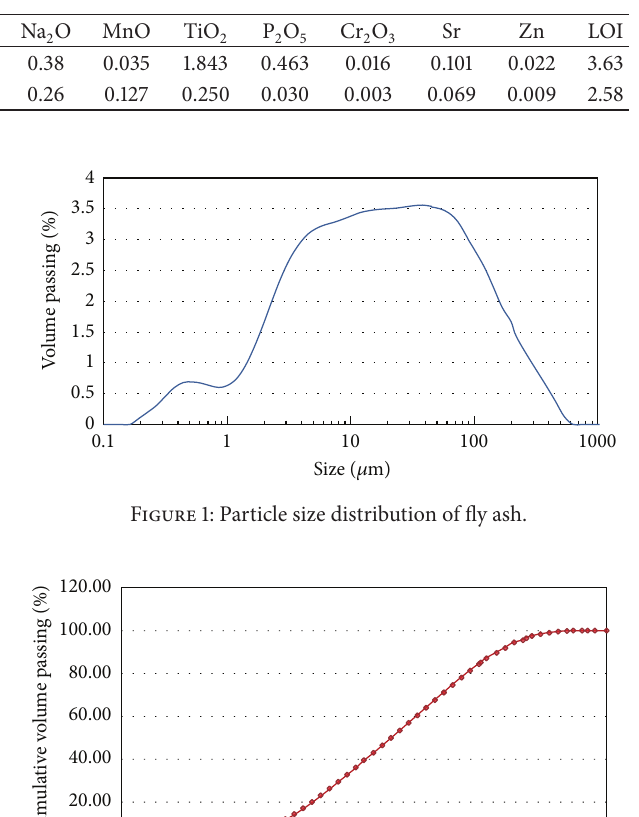
Table 1: Chemical composition of used fly ash and ordinary Portland cement (%).